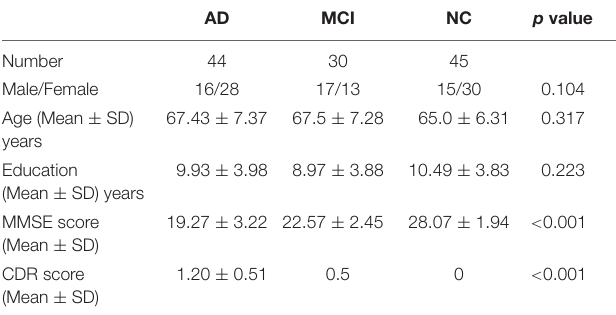
TABLE 1 | Demographic and behavioral